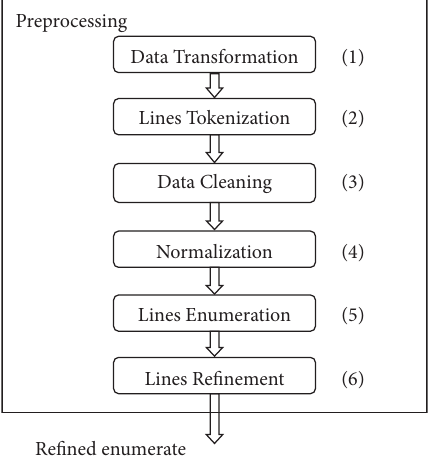
Figure 2: Te steps of the preprocessing stage.